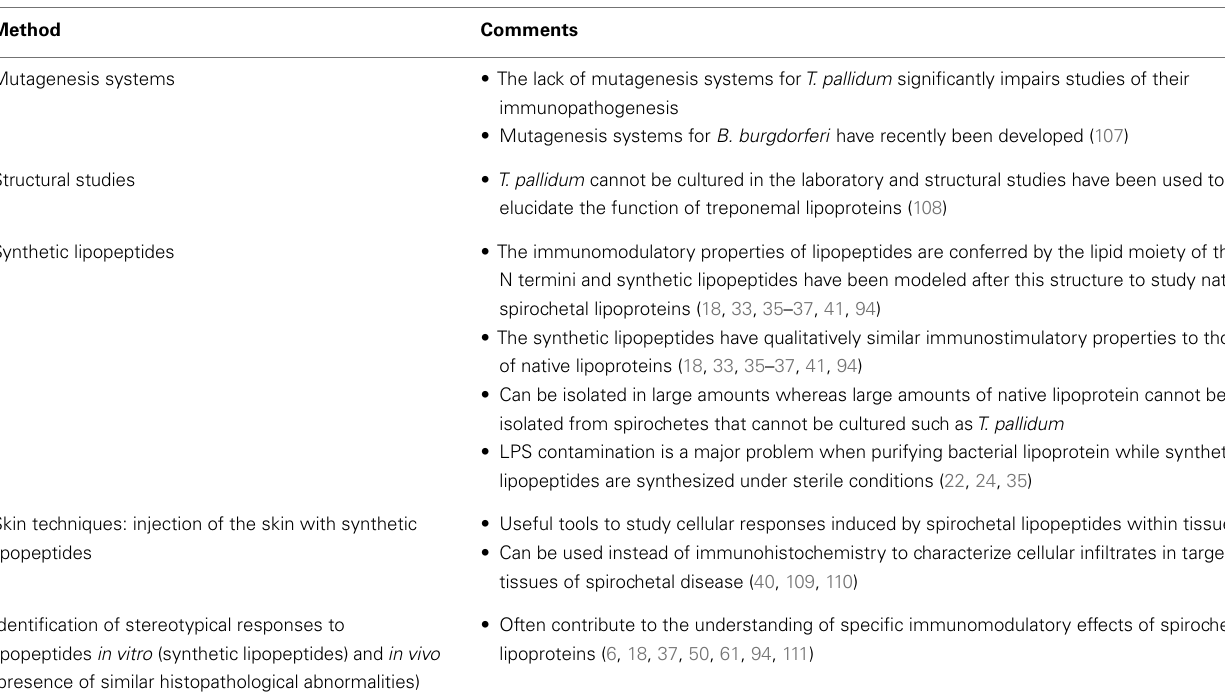
Table 2 | Methods used to determine in vitro and in vivo immunomodulatory properties of spirochetal lipopeptides/lipoproteins